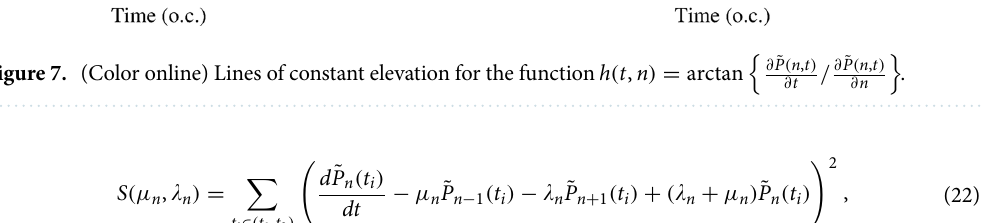
Figure 7. (Color online) Lines of constant elevation for the function h ( t , n )